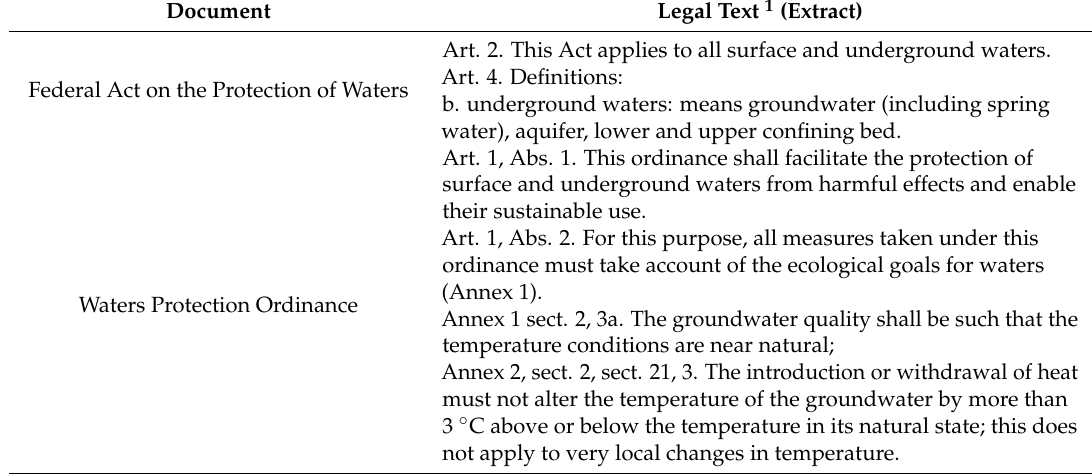
Table A2. Excerpts from the Waters Protection Act 814.20 of 24 January 1991 (Status as on 1 January 2017, Federal Assembly of the Swiss Confederation) and of the Waters protection Ordinance 814.201 of 28 October 1998 (Status as on 7 February 2016, Federal